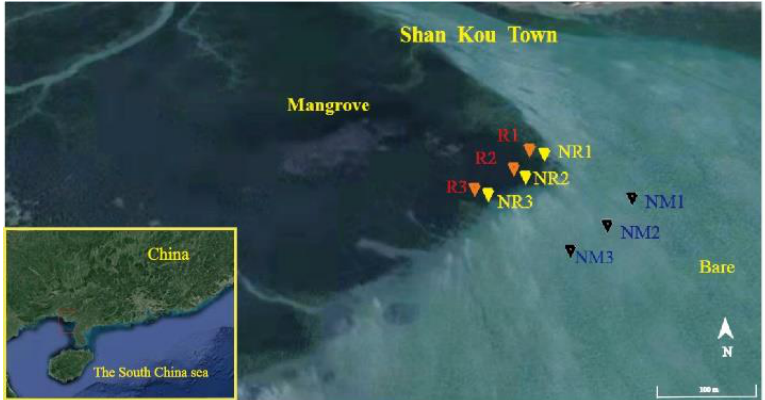
Figure 1. Geographic distribution of sampling sites in the subtropical mangrove ecosystem of Beibu Gulf in China. Sediment samples were collected from the National Shankou Natural Reserve of Mangrove in Beihai City (Site: 21°29′25.74″ N, 109°45′49.43″ E). Blue labels NMS1, NMS2, and NMS3 are the sampling sites of the non-mangrove sediments area (NMS). Red labels RS1, RS2, and RS3 are the sampling sites of the rhizosphere sediments area (RS); and yellow labels NRS1, NRS2, and NRS3 are the sampling sites of the non-rhizosphere area (NRS). Mangrove sampling sites include rhizo- sphere and non-rhizosphere sampling sites. RS1, RS2, RS3, NRS1, NRS2, and NRS3 were used as the group of MS.